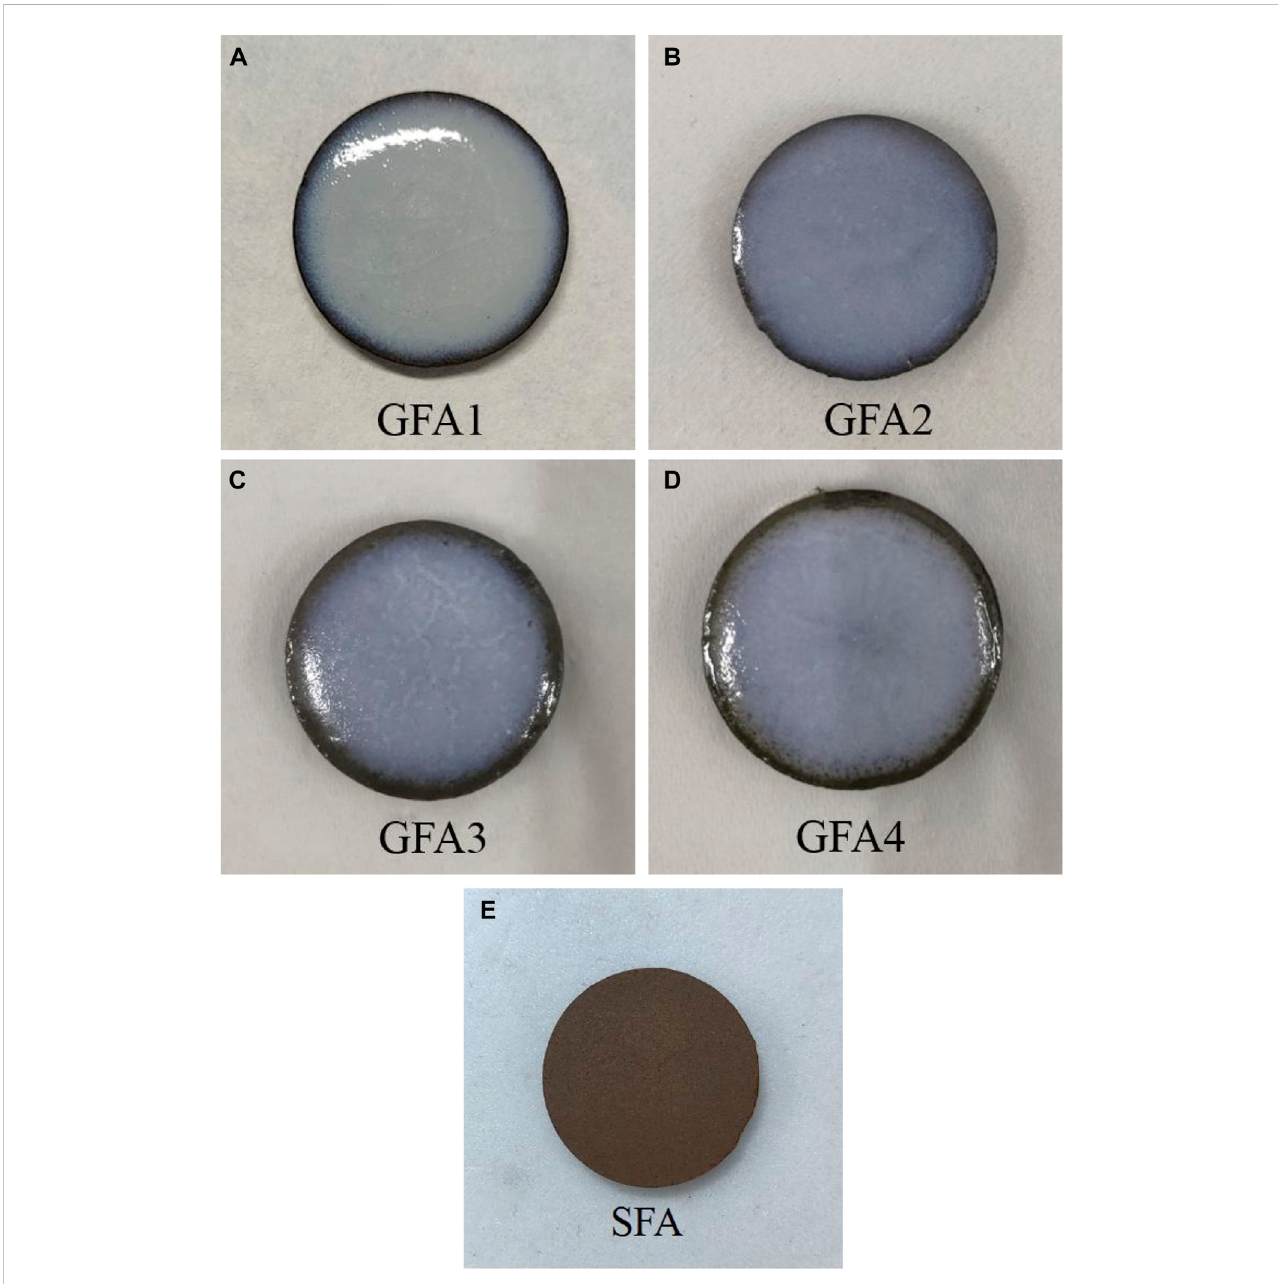
FIGURE 2 The digital photos of sintered samples ( (A) -GFA1-20wt% QS, (B) -GFA2-15wt% QS, (C) -GFA3-10wt% QS, (D) -5wt% QS, (E) -sintered body).